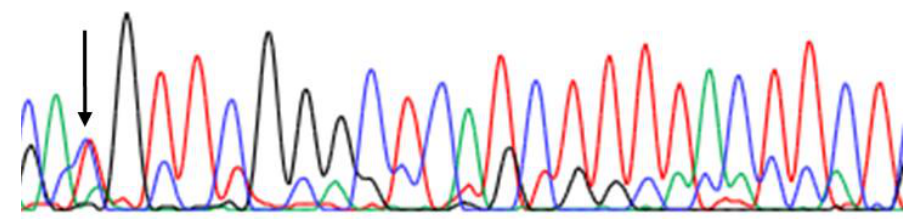
Figure 2. Sanger sequencing data of heterozygous PSEN2 Thr421Met mutation, indicated with